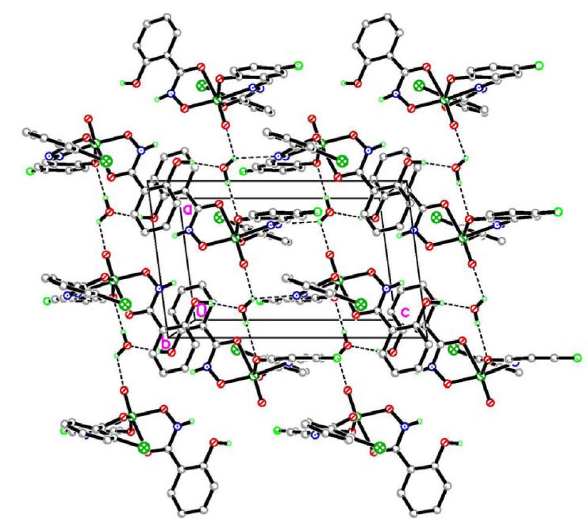
Figure 4. Molecular packing diagram of 2 . Viewed along the c axis. Hydrogen atoms not related to hydrogen bonding are omitted. Hy- drogen bonds are shown as dashed